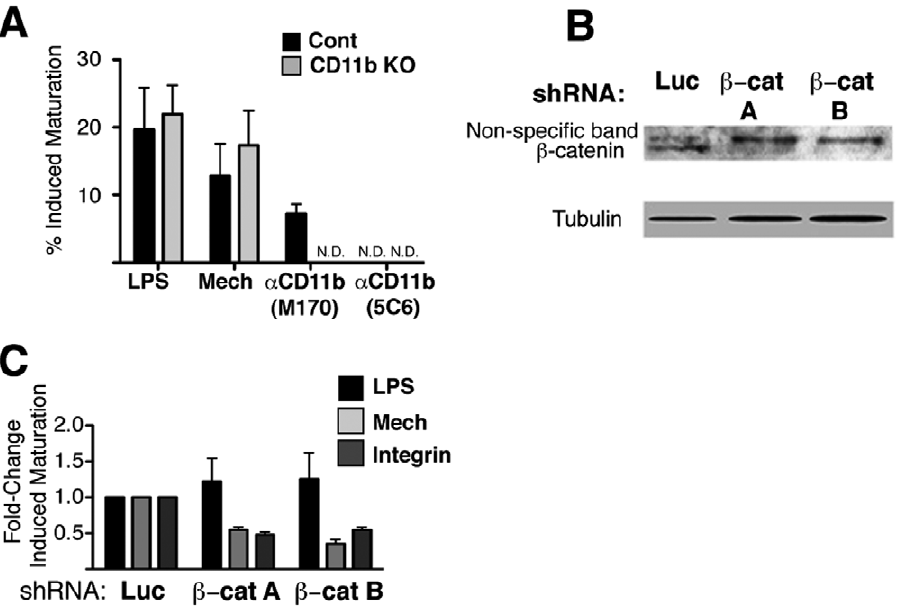
Figure 2. Tolerogenic Response to Mechanical Stimulation is Controlled by a Distinct Signaling Pathway. (A) Day 5 WT or CD11b -/- BMDCs were stimulated with 100 ng/ml LPS, with mechanical agitation, or by adding 1.5 ug/ml anti-CD11b (clones M170 or 5C6) to culture medium. 24 hours later maturation status was assessed by flow cytometry as in Fig 1. To correct for TGF- b -mediated differences in levels of spontaneous maturation, we calculate percent ‘‘induced maturation’’ as described in the methods section. The percentage of spontaneously mature DCs was comparable between WT and CD11b -/- .DCs Data from 3 experiments is summarized as mean 6 SEM. N.D. Not Detected. (B) BMDCs were infected with 2 independent lentiviral shRNA clones against b -catenin, or with control shRNA against luciferase. Cell extracts were prepared 6 days after infection and knockdown efficiency was confirmed by western blot. Blots are representative of 3 experiments. (C) BMDCs were infected as in (B). Infected BMDCs were stimulated with LPS, mechanical agitation, or by integrin stimulation ( a CD11b clone M170) and analyzed 24 hours later by flow cytometry. Data from 3 experiments is summarized as mean + /- SEM.